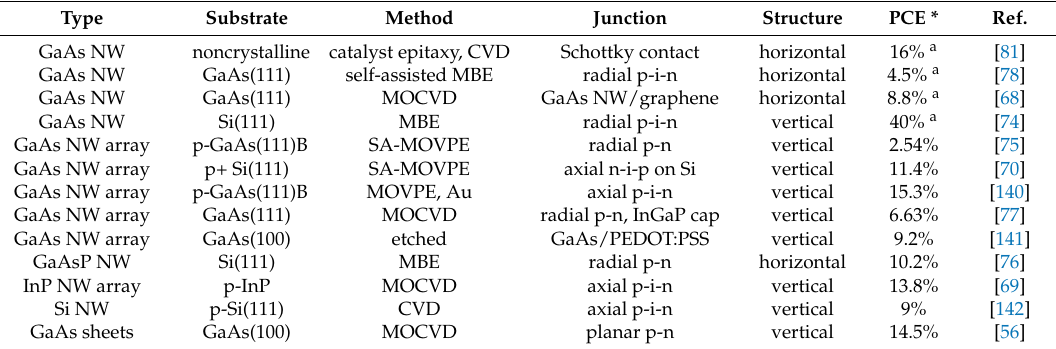
Table 1. Summary of GaAs and other NW-based PVs performance reported in recent